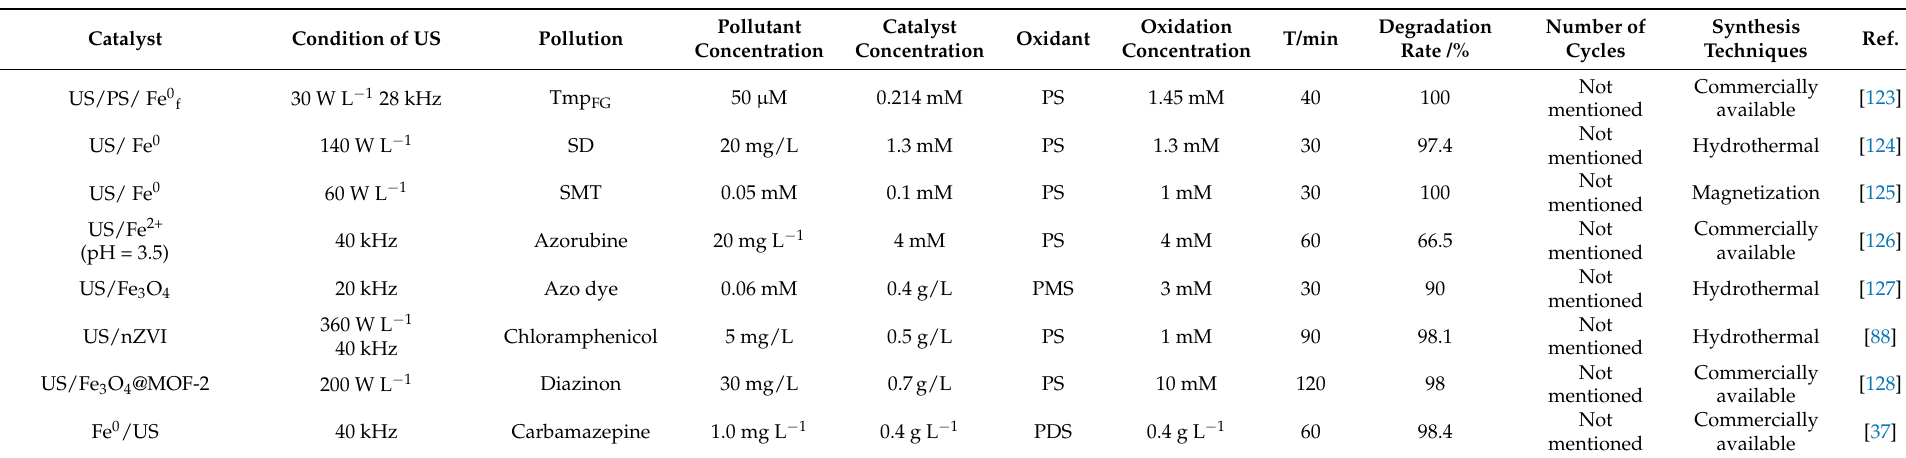
Table 6. Under the action of ultrasound, iron-based catalysts degrade different kinds of wastewater by activation persulfate